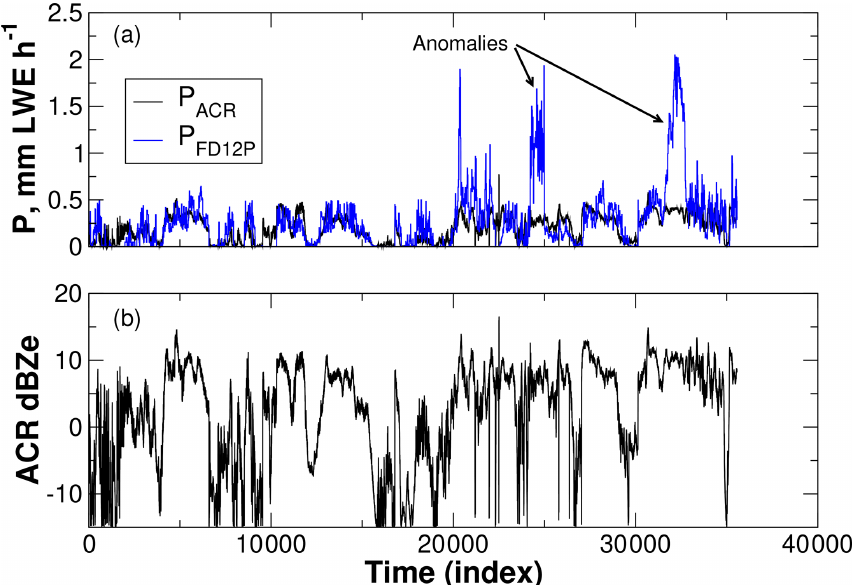
Figure 8. (a) Time series of snowfall rates retrieved from ACR reflectivities and observed. (b) Corresponding time series of ACR reflectivities. Each time index indicates a 2.8s observation by the ACR. Snowfall rates retrieved for the ACR used the reflectivity in the range bin nearest the surface, at